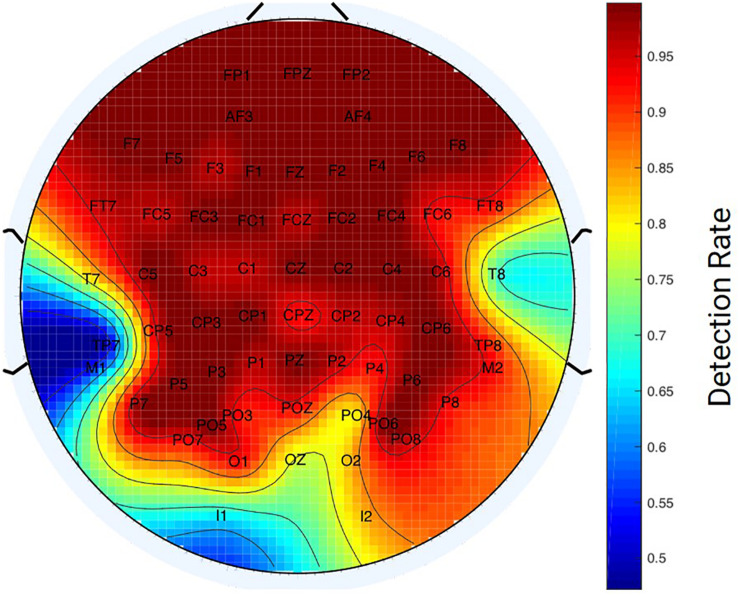
Detection Rate of Electrode Localization Method. Heat map of the mean accuracy for the localization of electrodes across 26 structural MRI scans. Areas indicated in red reflect high detection rate, while areas in blue reflect low detection rate for identifying electrodes.